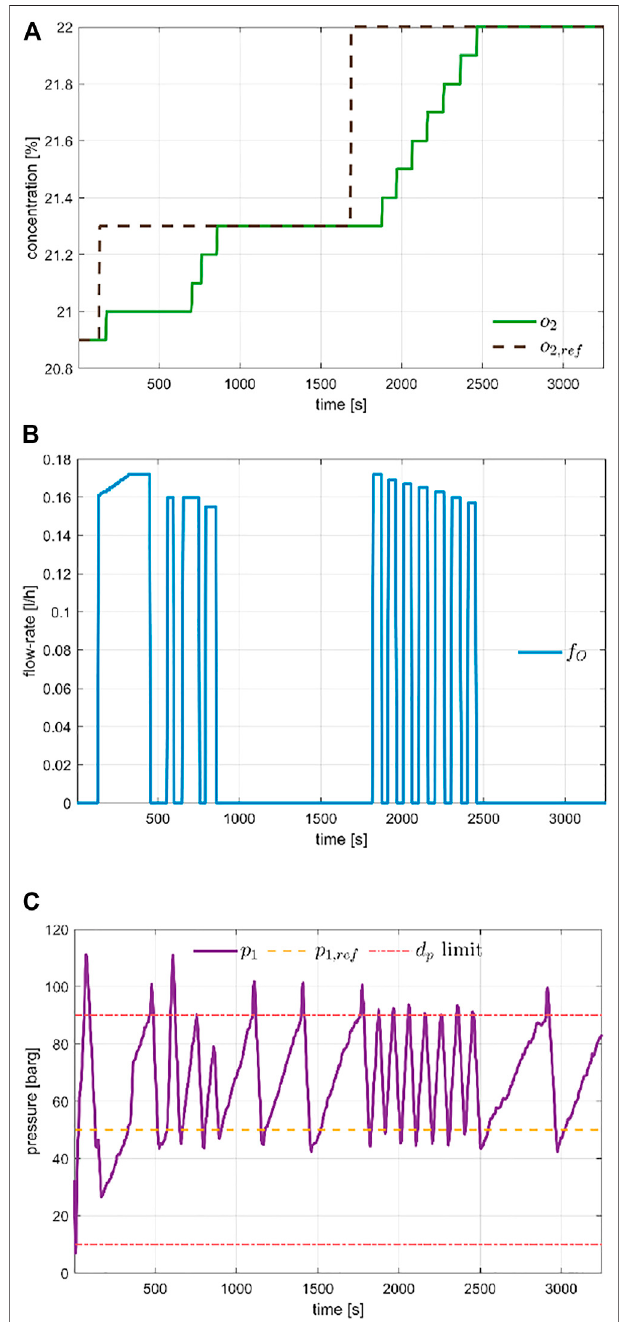
FIGURE 6 | Evaluation of O 2 recovery control, for different set-point values. Plot (A) shows the tracking performance, Plot (B) the actuation valve position and Plot (C) the simultaneous control of the chamber pressure that limits the O 2 injection.